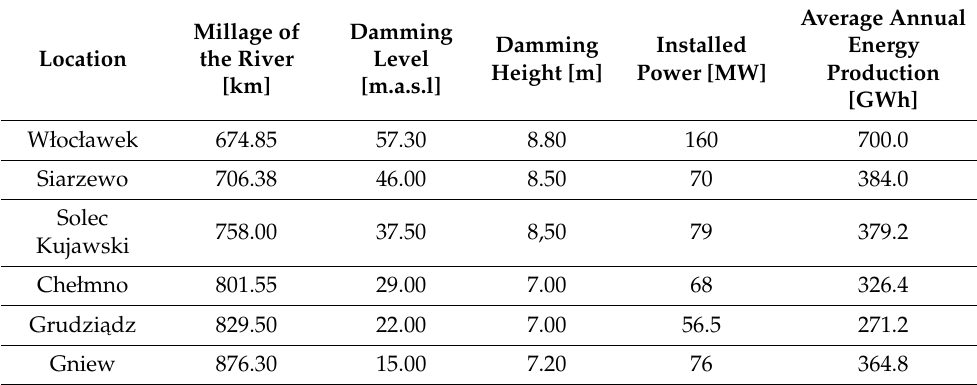
Table 1. Characteristics of the barrages included in the planned Lower Vistula Cascade.